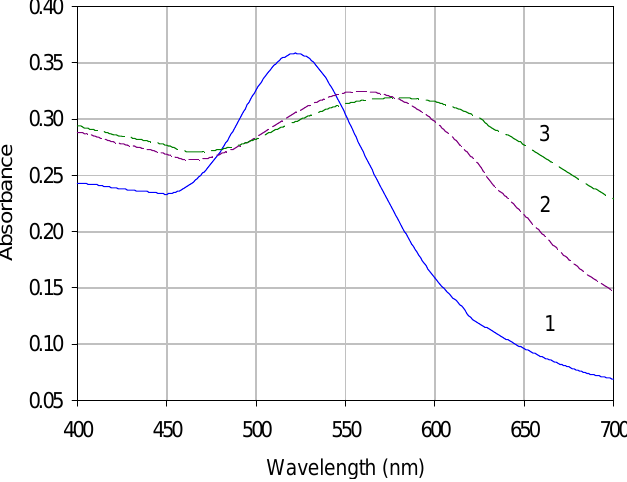
Figure 2. UV-Visible spectrum of (1) gold nanoparticles (AuNP), (2) glutathione capped AuNP and (3) lipoic acid capped